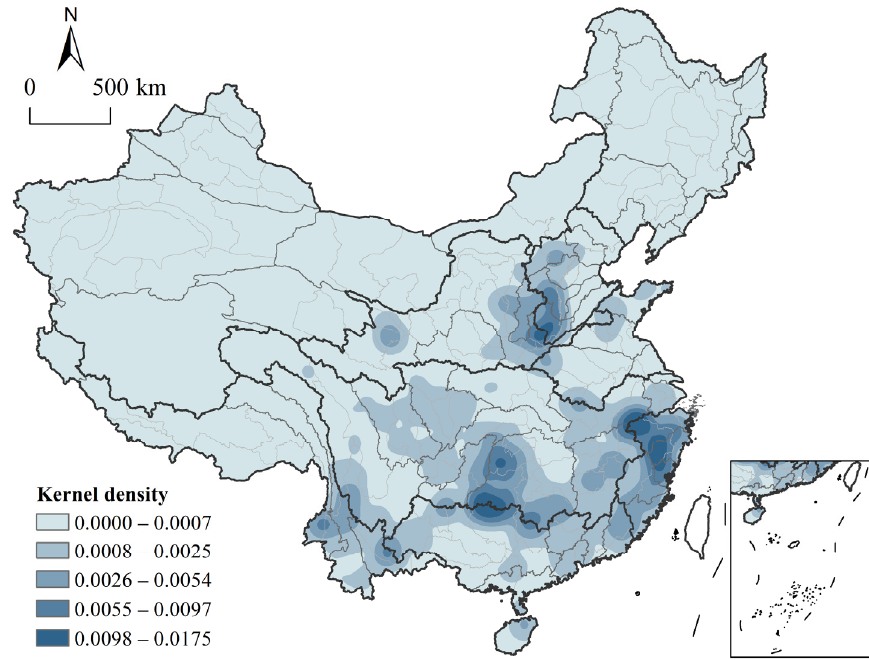
Figure 3. Kernel density map of traditional villages in China.